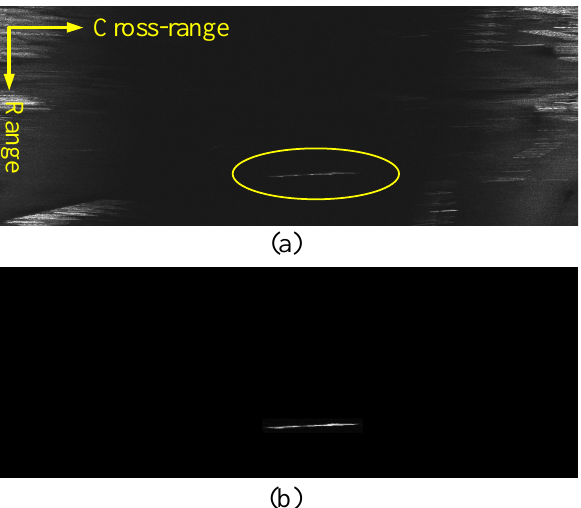
Figure 6. Moving target detection for T1. ( a ) Range–Doppler domain. ( b ) Moving target detection